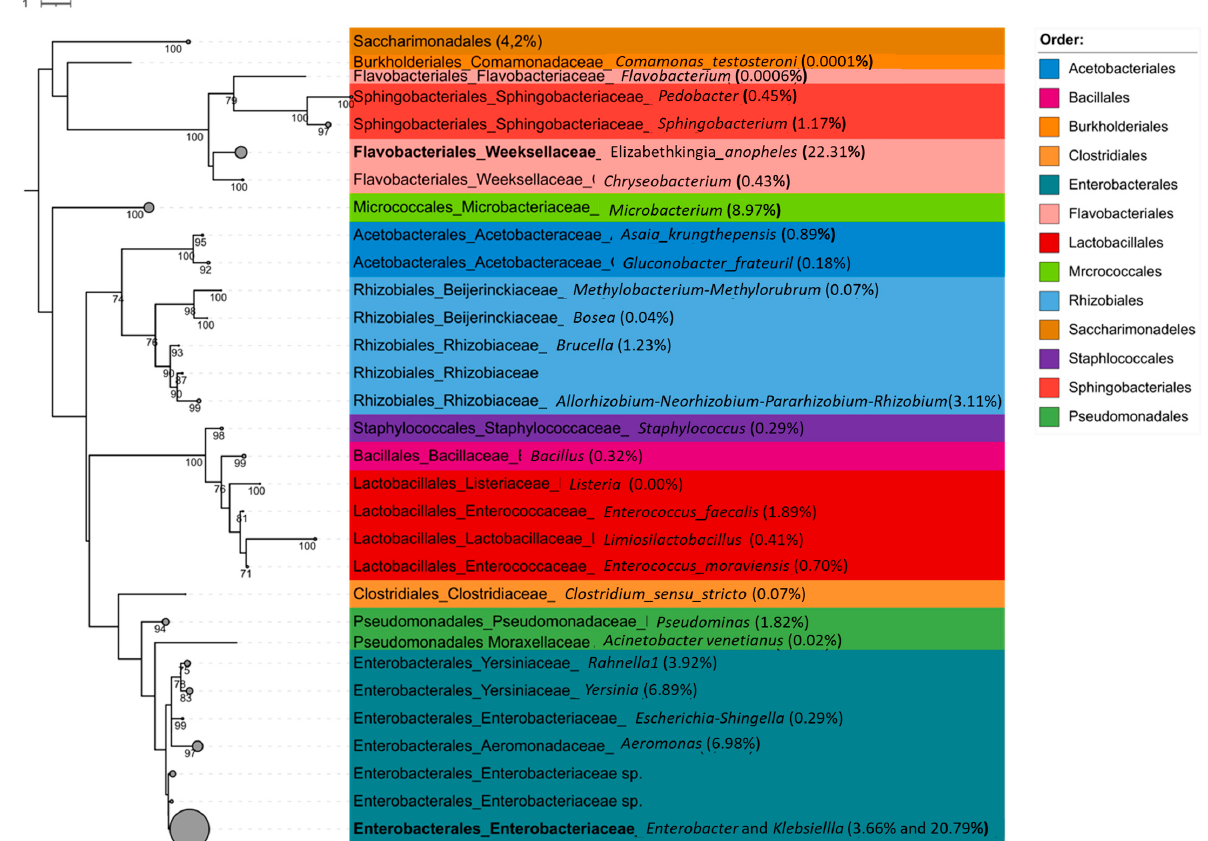
Figure 6. Phylogenetic tree of 16S rRNA sequences from Anopheles merus adults and larvae from different salt concentrations. Using the alignment of classified OTU sequences, the maximum likelihood tree was constructed using RAxML with the GTRGAMMAIX model and 1000 bootstraps. Taxa under the same genus were collapsed and their overall OTU abundance percentages are provided within the parentheses.